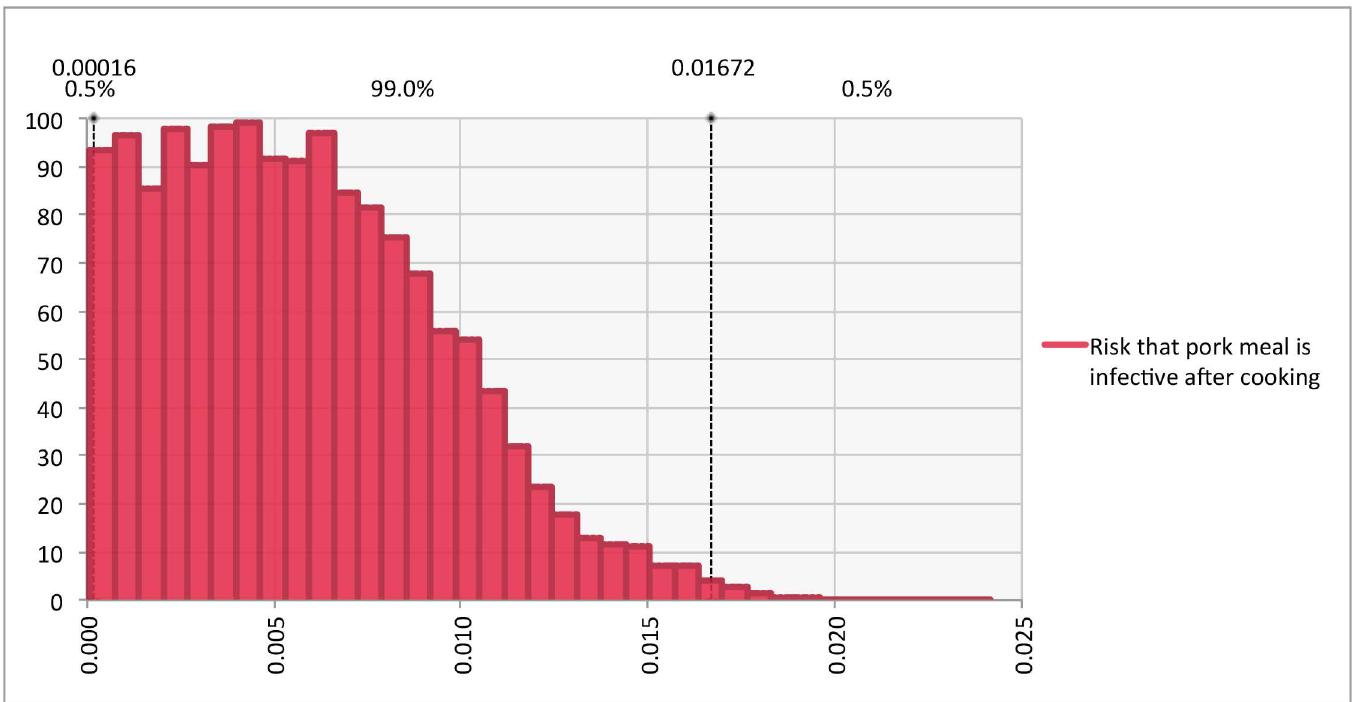
Fig 2. Relative frequency histogram illustrating risk of any one pork meal being infected with a viable T . solium cysticercus at